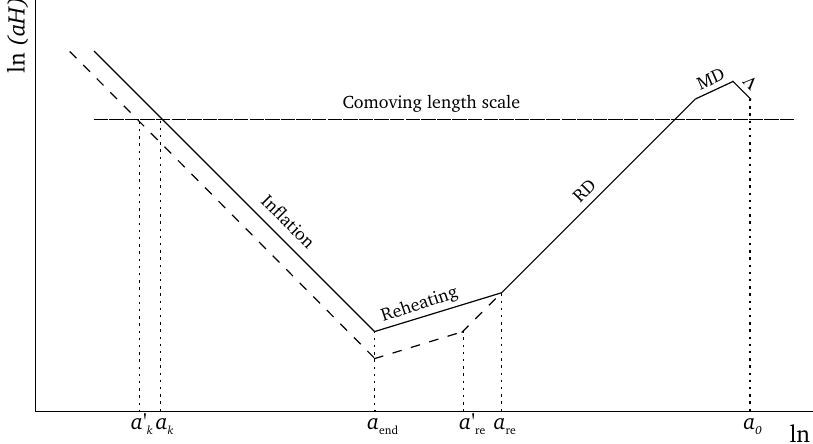
Figure 1. Evolution of the comoving Hubble horizon in di(cid:11)erent epochs of cosmic history. RD, MD and (cid:3) indicate the radiation dominated era, matter dominated era and the current era of accelerated cosmic expansion, respectively. H is Hubble parameter and a the scale factor. a k ; a end ; a re and a 0 are the values of the scale factor at the horizon crossing of a reference mode with a comoving wave number k , the end of in(cid:13)ation, the end of reheating and the present time, respectively. The di(cid:11)erent slopes are a result of the di(cid:11)erent equation of state in di(cid:11)erent epochs. In order to visualise the e(cid:11)ect of the reheating era on the horizon crossing point, we used two line styles: solid line corresponds to the small dissipation rate (cid:0), i.e. the large e -fold number of reheating N re and dashed line corresponds to the relatively large value of (cid:0), i.e. small N re . In both cases we have assumed that the equation of state parameter w re remains approximately constant during reheating; if this were not the case, the slope of the lines would change during reheating. Our analysis, however, does not rely on this assumption because the e(cid:11)ect on the CMB only depends on the average value (cid:22) w re , cf. eq. (1.1). For the larger (cid:0), the end of reheating lies further back in time. As a result, the inferred values for the scale factor at that moment and at the moment of horizon crossing decrease, as can be seen by comparing a re and a k to a 0 and a 0 . This implies that the horizon crossing happens at the larger re k (cid:12)eld value (cid:30) k if (cid:0) is larger, where the slow-roll parameters are more suppressed, and hence the spectral index n s gets closer to 1. Conversely, a larger n s implies a larger (cid:0). Assuming that (cid:0) is a monotonically increasing function of the in(cid:13)aton’s coupling constant to radiation, the coupling constant is an increasing function of n s